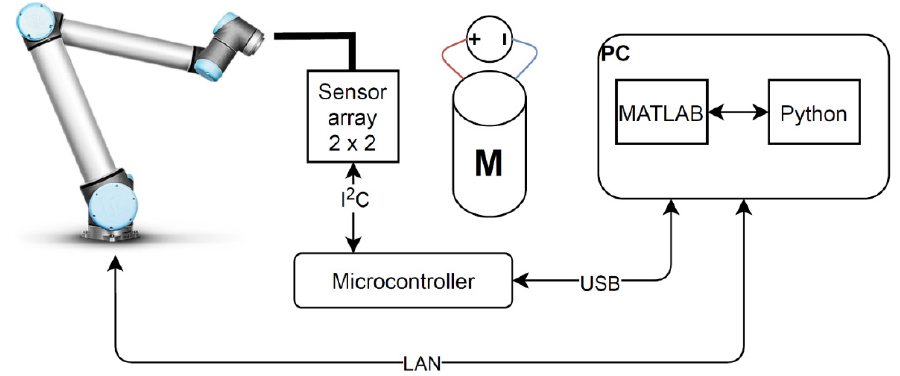
Figure 4. Experimental setup schematic.